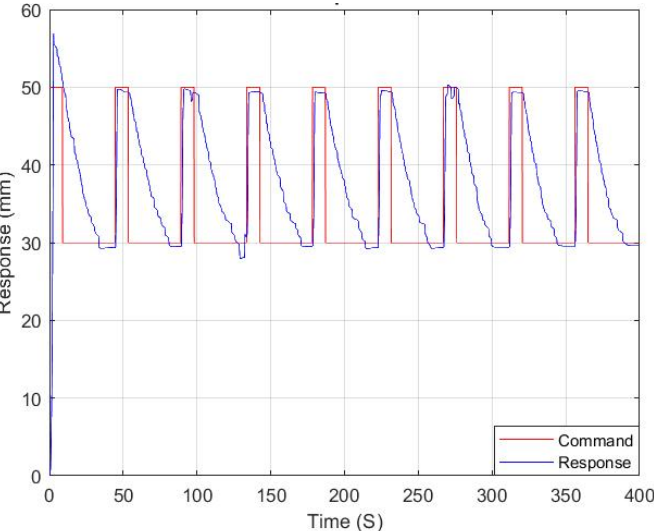
Figure 14. A closed-loop displacement control of the square command signal.